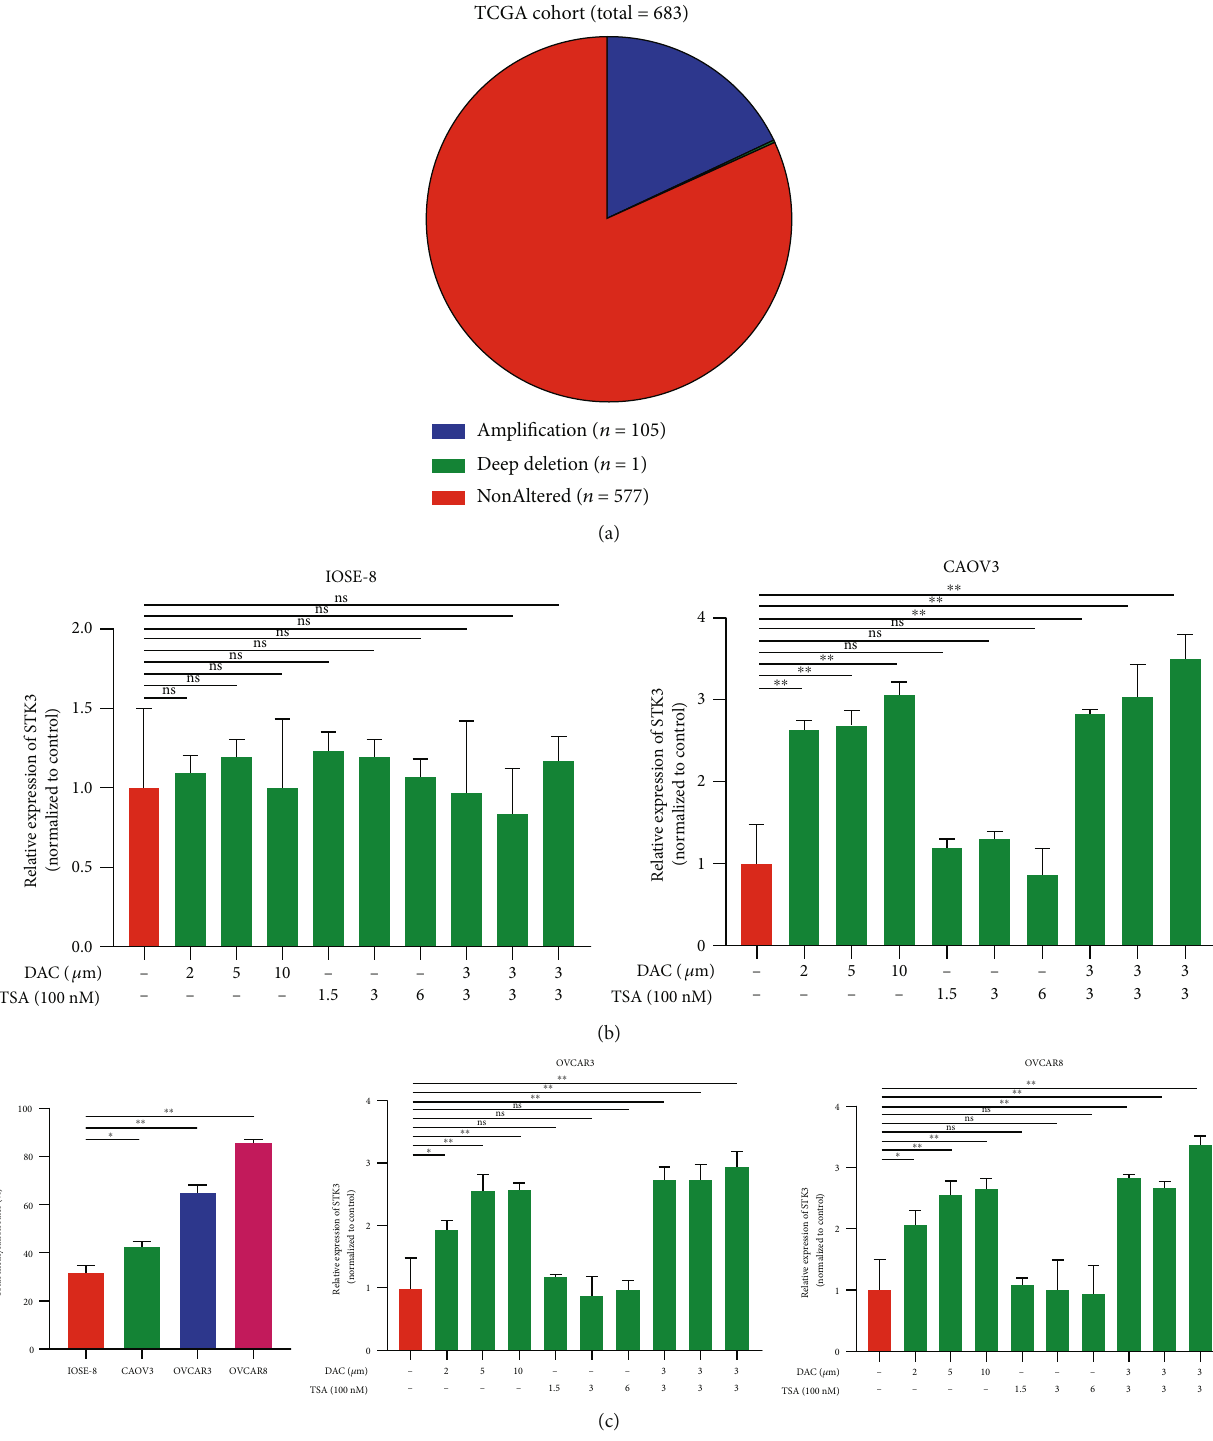
Figure 3: The STK3 expression in ovarian cancer cell lines. (a) Statistics of STK3-mutated samples derived from 683 patients in cBioportal. (b) The mRNA expression of STK3 was evaluated by real-time qPCR in cell lines (IOSE80, CAOV3, OVCAR3, and OVCAR8) treated with DMSO, DAC, TSA, or DAC plus TSA (two-tailed Student ’ s t -test, ∗∗ P < 0 : 01 ). (c) Total methylation rates of STK3 promoter in the human osteoblast cell line IOSE80 and three ovarian cancer cell lines (CAOV3, OVCAR3, and OVCAR8) are shown. (two-tailed Student ’ s t -test, ∗ P < 0 : 05 , ∗∗ P < 0 : 01